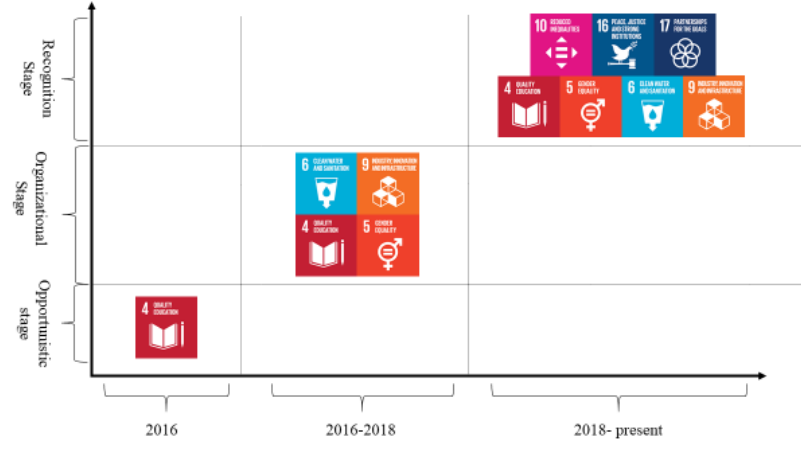
Figure 2. BBU’s Contribution toward the SDGs.